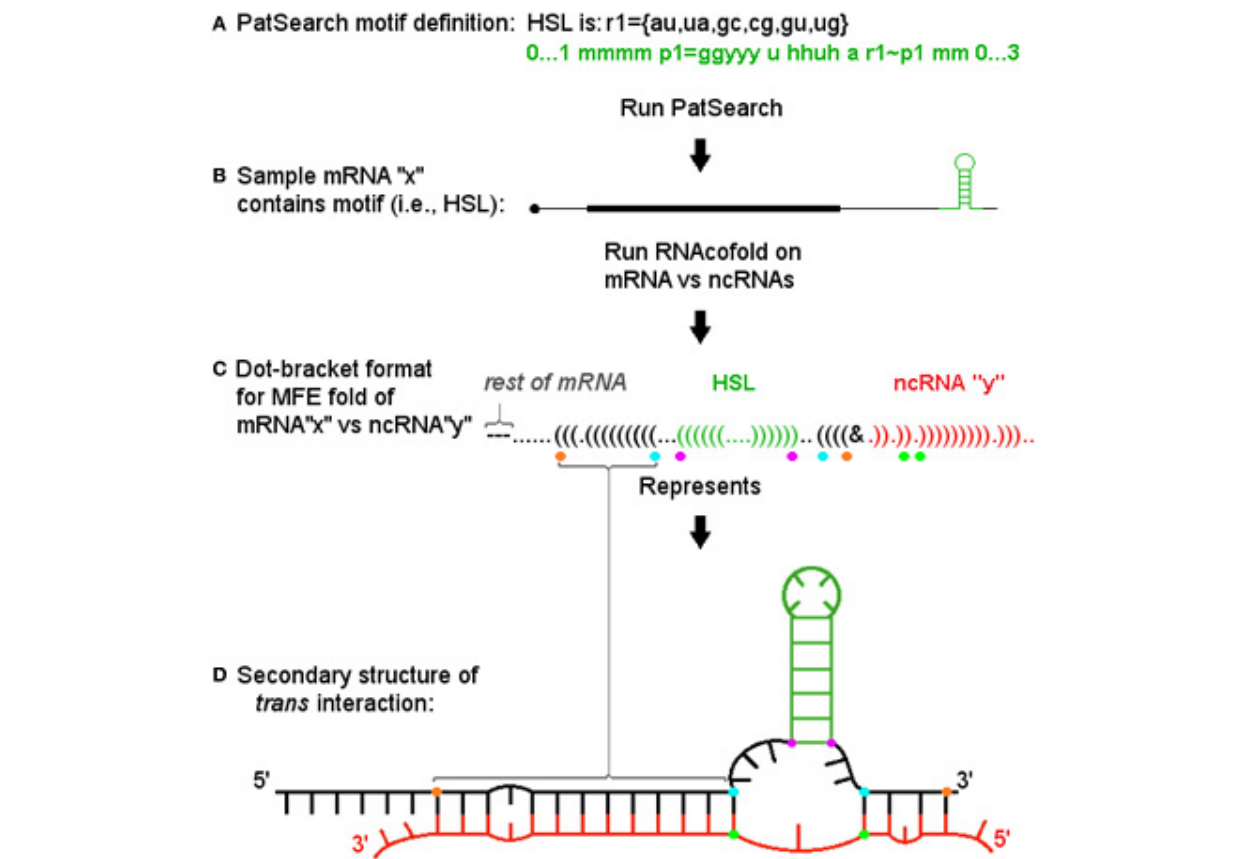
FIGURE 2 | Informatic approach and pipeline for identifying trans 3-way junctions. (A) The PatSearch program is used to identify a subset of mRNAs from Refseq that contain a defined motif. Motif location within each mRNA is retained. (B) Each motif (shown in green) containing mRNA (here a single representative, “x,” is shown) is run through RNAcofold vs. each ncRNA in query set (e.g., “mirBase”) for both whole message as well as a ± 25 b sequence window surrounding motif. (C) Each resulting minimum free energy (MFE) fold’s (here a single example fold with ncRNA, “y,” is shown) dot-bracket output was parsed using the known location of the motif to i. ascertain if motif structure is present (again, in green), ii. determine if the ncRNA (shown in red) hybridizes across the motif’s base, iii. then, if both these conditions are met, to identify positions defining critical segments for scoring the sxRNA. These positions